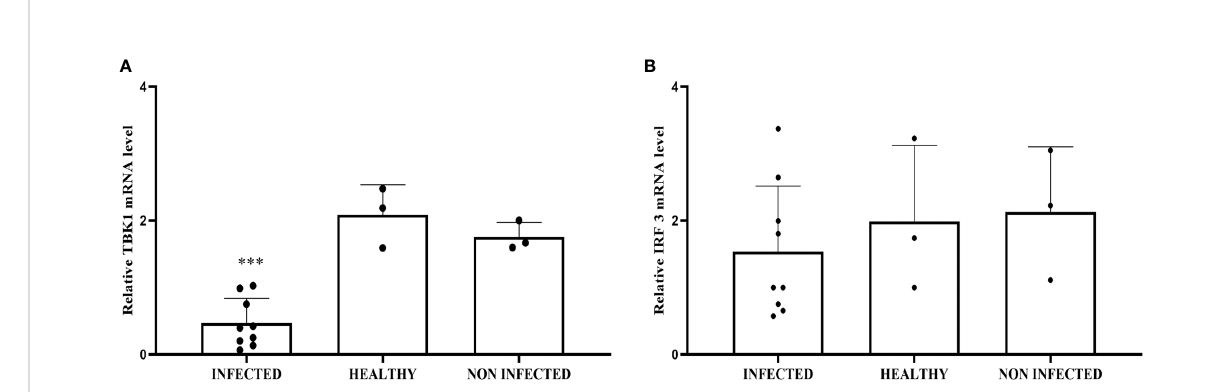
FIGURE 7 (A) RT-qPCR analysis of TBK1 mRNA levels in infected, non-infected, and healthy bladder samples, respectively. TBK1 mRNA expression was signi fi cantly reduced in infected samples compared with healthy bladder (***p ≤ 0.001). (B) RT-qPCR analysis of IRF3 mRNA levels in infected, non-infected, and healthy bladder samples, respectively. There was no statistically signi fi cant variation in IRF3 mRNA expression level in infected bladder tissues compared with that in both non-infected and healthy bladder